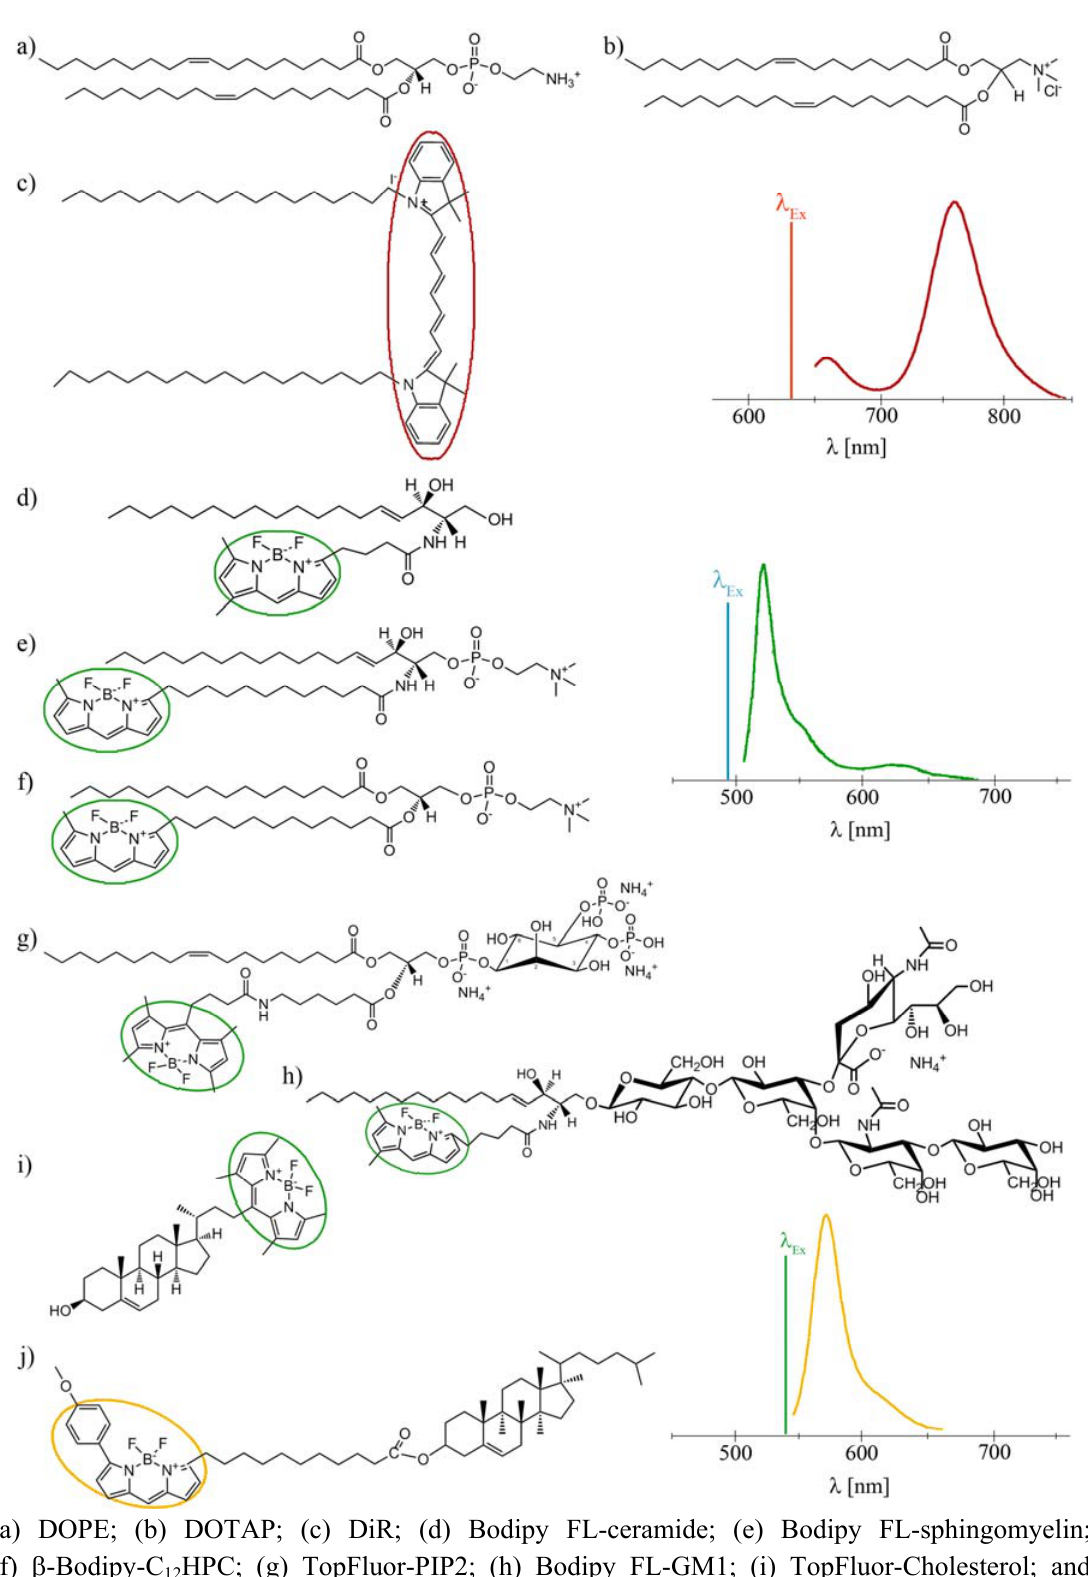
Figure 1. Molecular structures and fluorescence spectra of the lipid derivates used in this